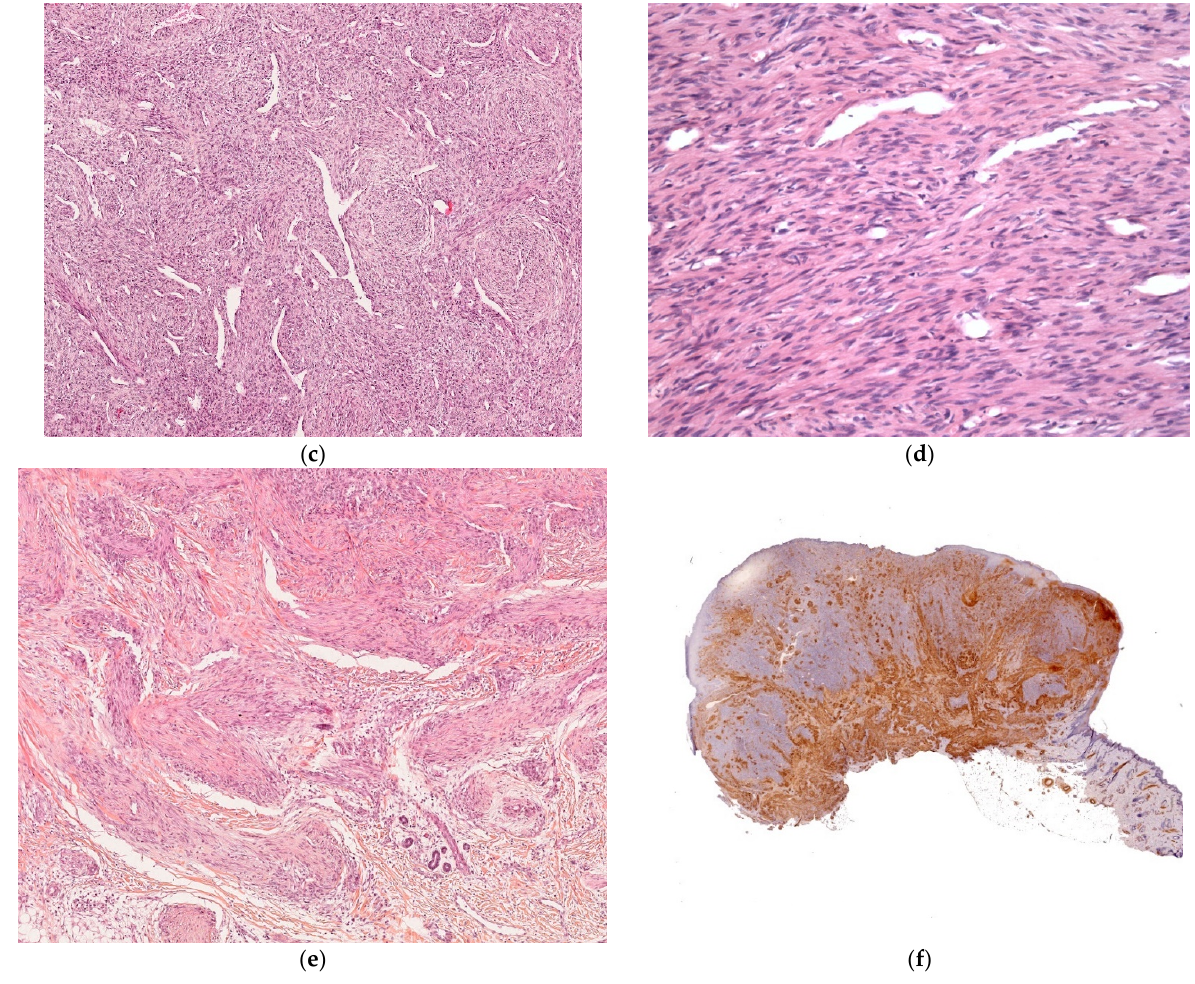
Figure 10. Infantile myofibromatosis. ( a ) This baby presented with multiple small blueish lesions. ( b ) 4× dermal rounded well-circumscribed lesion. ( c ) 10× antler-shaped vascular proliferation associated with spindle-shaped cells in the center of the lesion. ( d ) 25× spindle-shaped cells arranged in fascicles. ( e ) 10× round lobules made up of elongated cells with poorly seen cytoplasmic borders at the periphery of the lesion. ( f ) 4× anti-SMA.